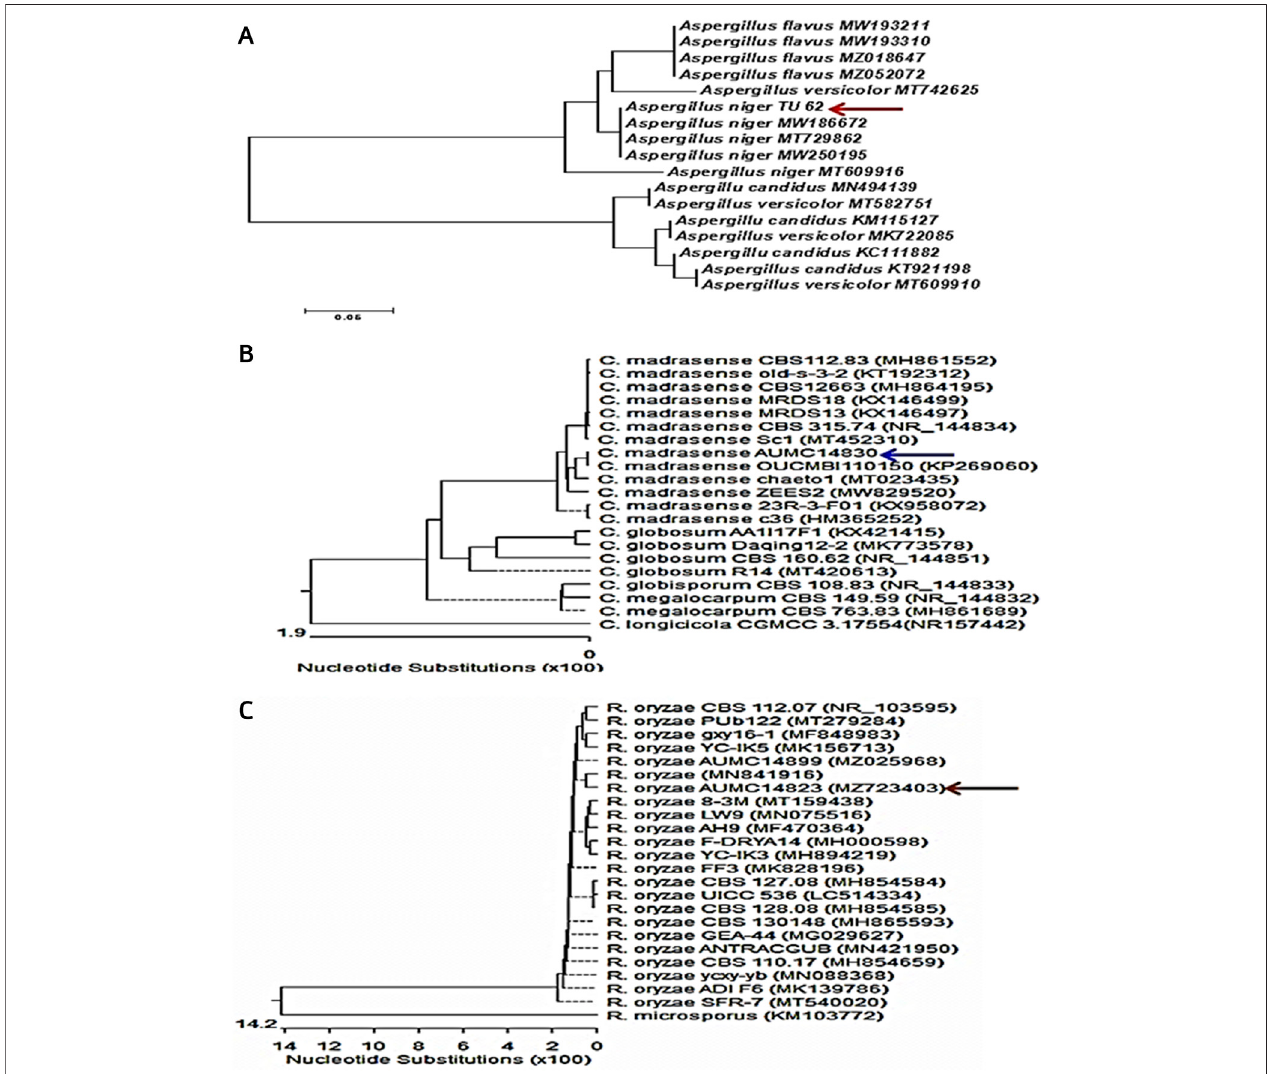
FIGURE 1 | Neighbor-joining phylogenetic tree showing the genetic diversity of fungal isolates based on ITS sequences of tested fungi aligned with closely-related strains accessed from GenBank: (A) A. niger TU62; (B) C. madrasense AUMC14830; (C) R. oryzae AUMC14823.